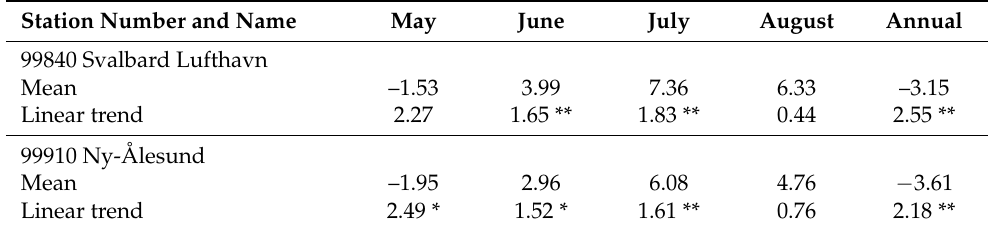
Table 1. Monthly and mean annual temperature (°C) for the two meteorological stations Svalbard Lufthavn and Ny-Ålesund based on data from the Norwegian Centre for Climate Services [15]. Temperatures for the period 2000–2020 were analyzed, and, assuming a linear trend, ** p < 0.01, * p < 0.05.